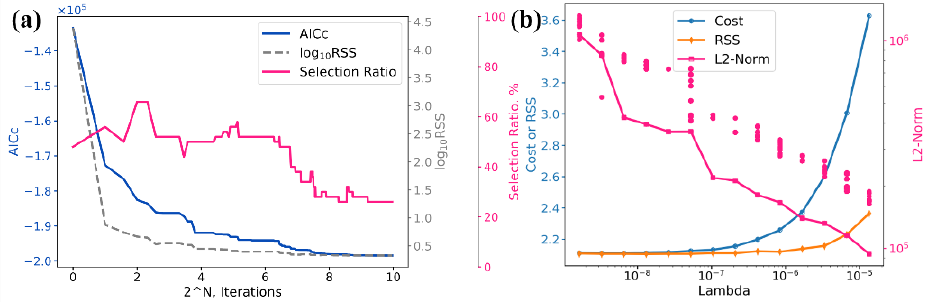
Figure 1. Convergence sequence of the parameter selection strategy and the regularization strategy: ( a ) Parameter selection strategy; ( b ) Regularization strategy. ( a ) Parameter selection strategy; ( b ) Regularization